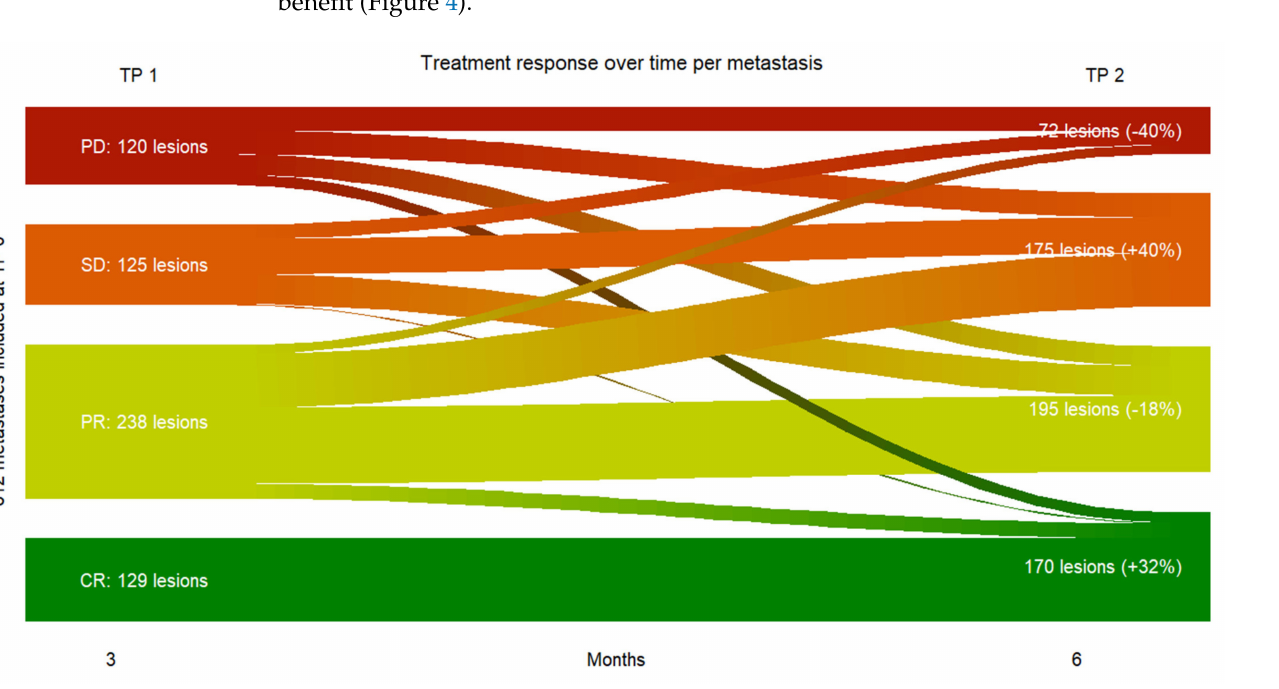
Figure 4. Sankey plot of treatment response over time from TP 0 to TP 2 per metastasis. In total, 612 melanoma metastases were included at TP 0. From the top to the bottom: Treatment response per metastasis. Progressive Disease PD in red; Stable Disease SD in orange; Partial Response PR in lime-green; Complete Response CR in green. From left to right: Time point baseline TP 0; three months after initiating immunotherapy TP 1; six months after initiation immunotherapy TP